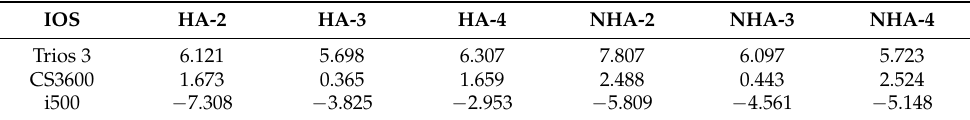
Table 3. Values of the Standard J–T Statistic in the HA-2, HA-3, HA-4, NHA-2, NHA-3, and